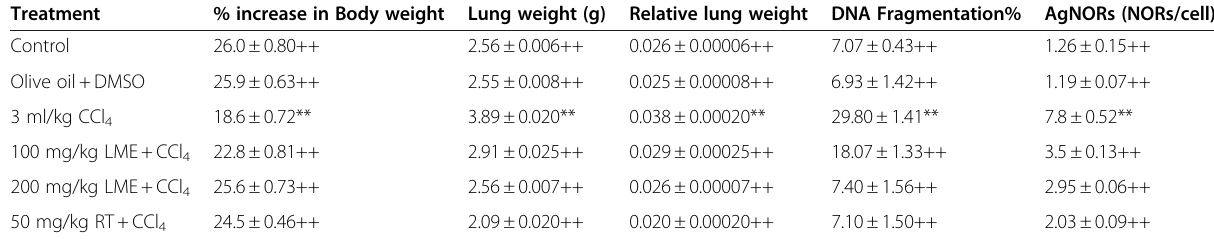
Table 3 Effect of LME on lung weight, relative lung weight, AgNORs count and DNA damages in rat